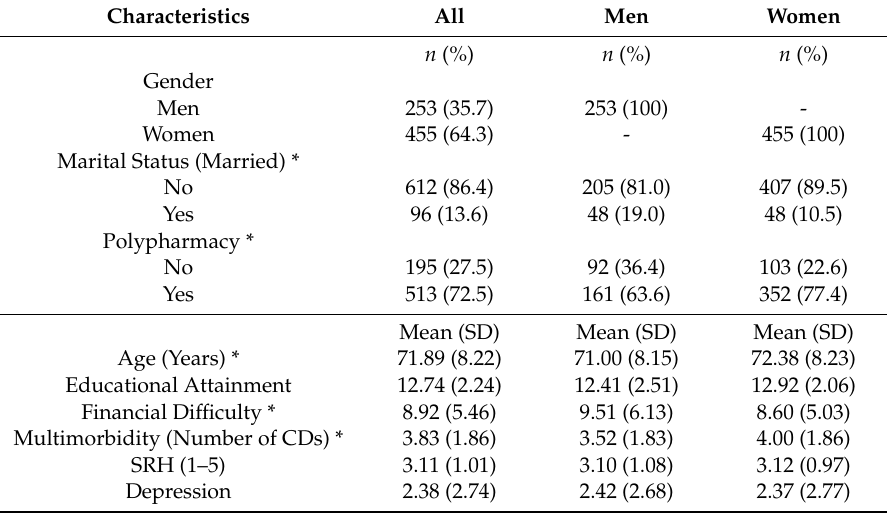
Table 1. Descriptive characteristics in the pooled sample and by gender.